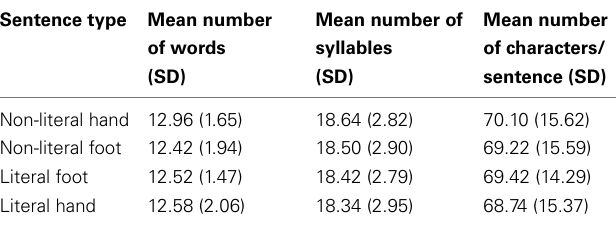
Table 2 | Means for each sentence